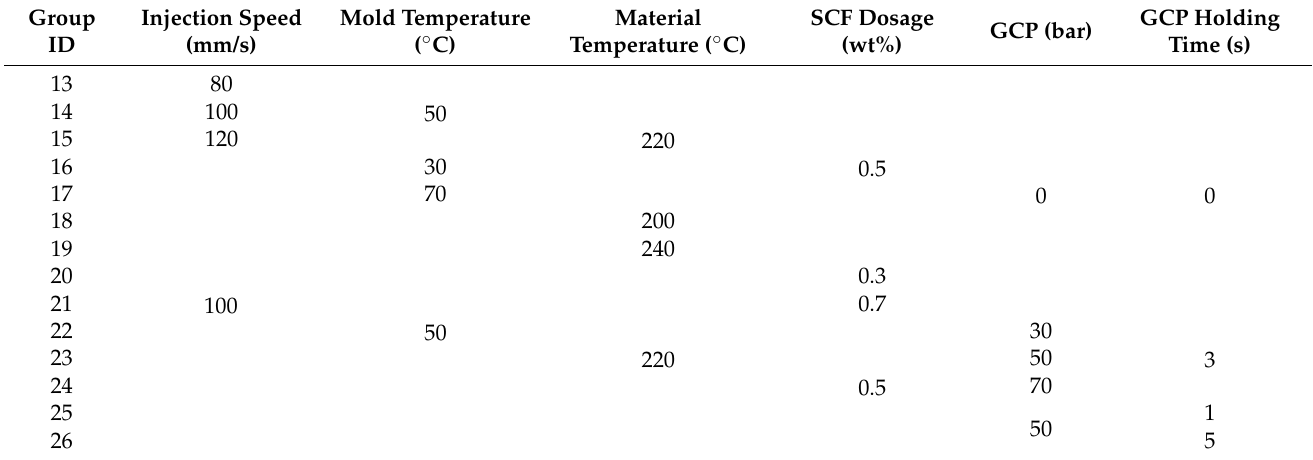
Table 2. Processing conditions for MuCell injection molding without (ID 13–21) and with GCP (ID